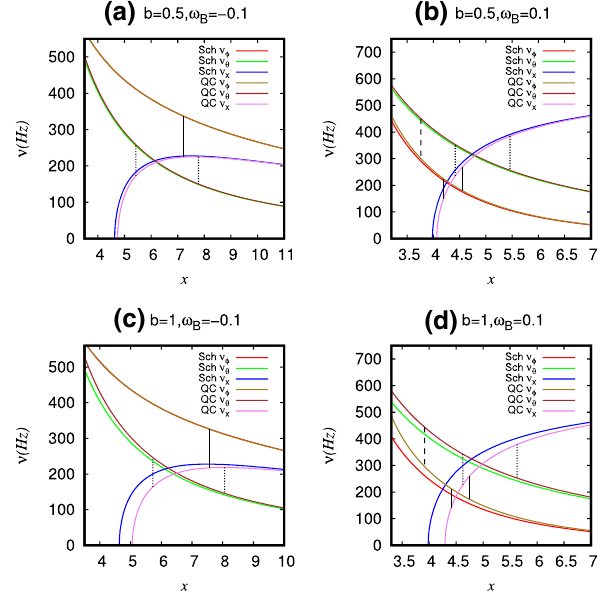
Fig. 15 The epicyclic frequencies for quantum-corrected Schwarzschild black holes (“QC”) and Schwarzschild ones (“Sch”) immersed in an external uniform magnetic field. Black solid vertical lines denote the positions of 3:2 resonance in between ν x and ν ϕ , black dotted vertical lines denote the positions of 3:2 resonance in between ν θ and ν x and black dashed vertical lines denote the positions of 3:2 resonance in between ν θ and ν